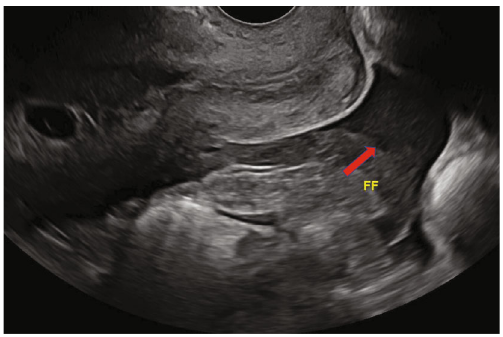
Figure 4: Sagittal transvaginal ultrasound image of the cervix with the posterior cul-de-sac with free fl uid concerning for hemorrhage (red